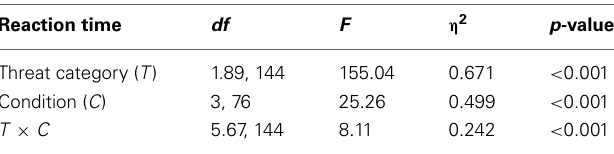
Table 5 | Results of pairwise comparisons with Bonferroni correction for the sums of reaction times (in seconds) of all four conditions (SPSS Bonferroni adjusted p -values are